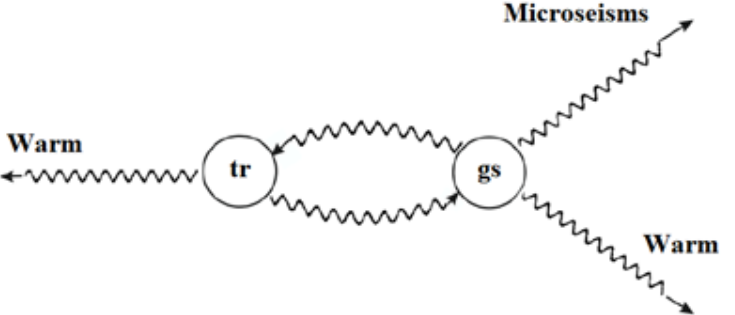
Figure 1. Self-oscillatory process in the interaction between tr-cracks and gs-cracks. The first type of cracks are seed cracks with lower energy and, when the critical concentration level is reached, it passes into the second type. Cracks of the second type are a source of microseismic phenomena (oscillations) and, after the release of their en- ergy, they partially disappear and partially pass into seed cracks (the Le Chatelier–Brown principle, [3]). Further, this self-oscillatory process is